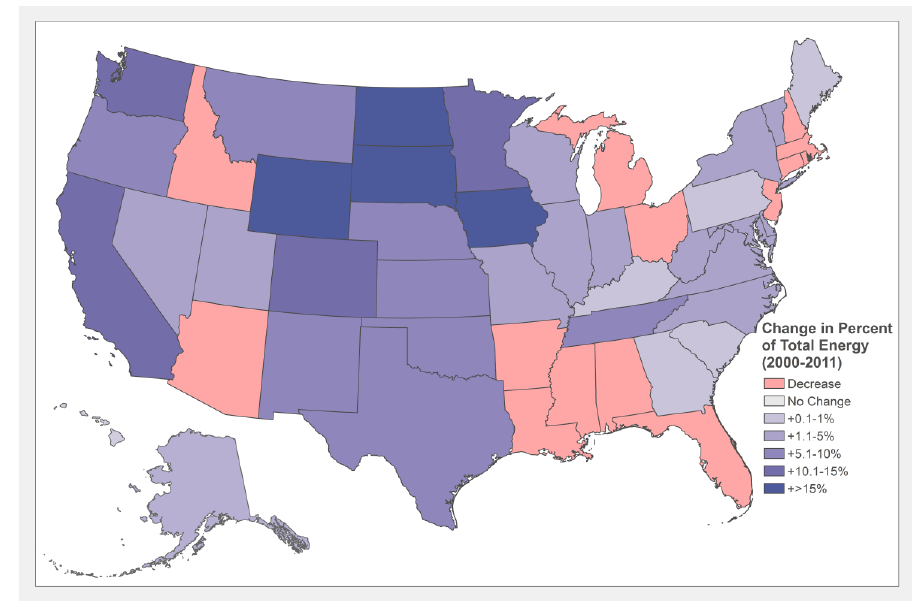
Figure 6. Change in percent of total electricity generation produced from renewable sources by state. Renewable energy sources included: conventional hydroelectric, geothermal, wood and wood derived fuels, other biomass, wind, solar thermal and photovoltaic. Categories classified and data provided by US EIA